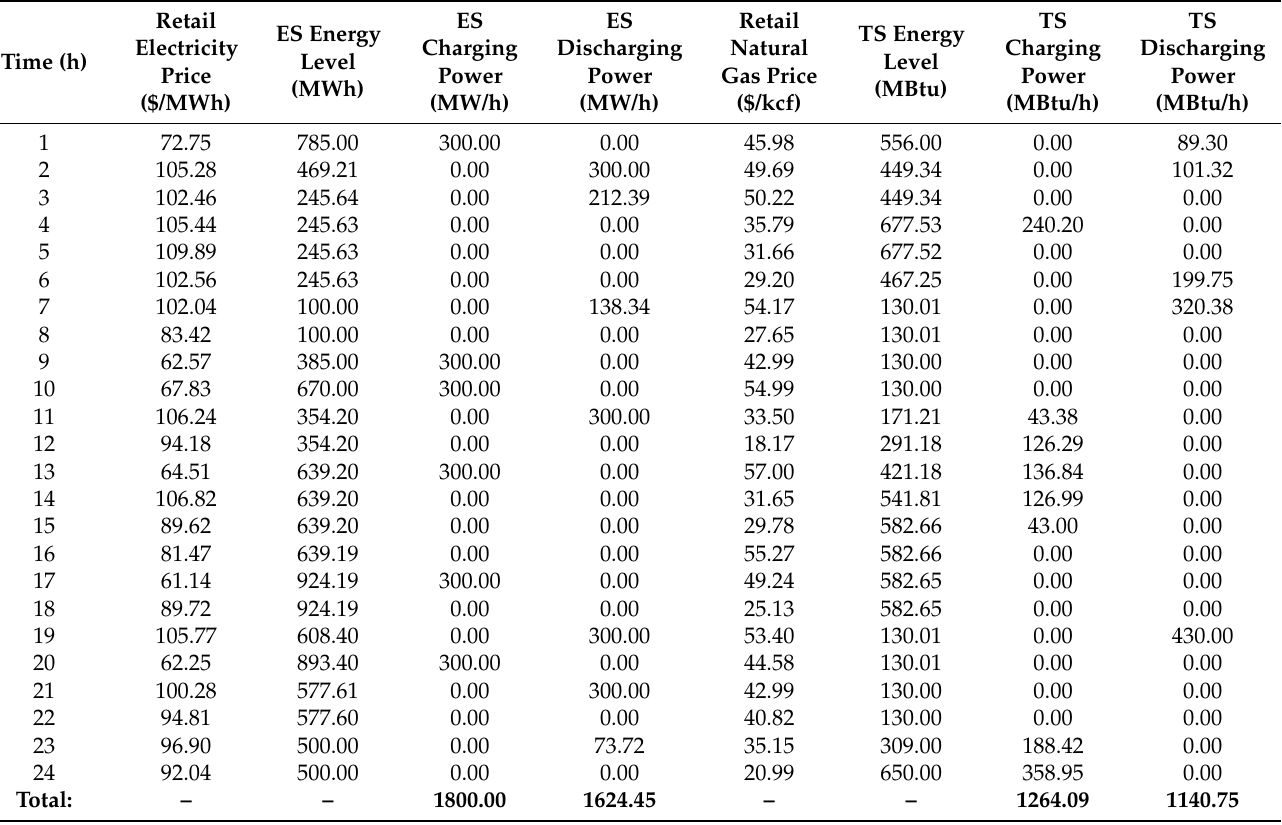
Table 9. ES and TS results for microgrid 3. – : Not applicable